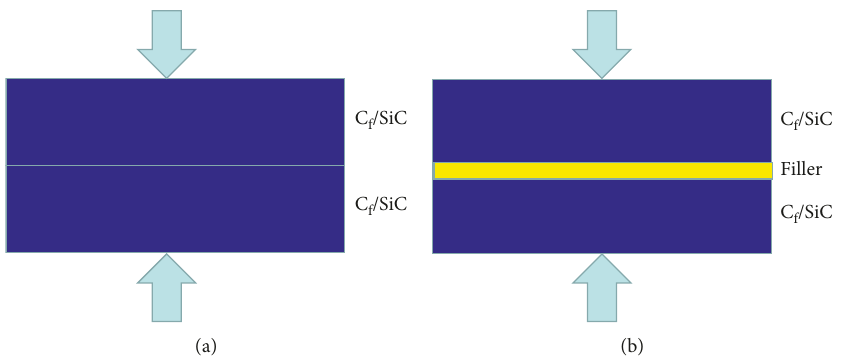
Figure 2: The diagram of (a) direct bonding and (b) indirect bonding.